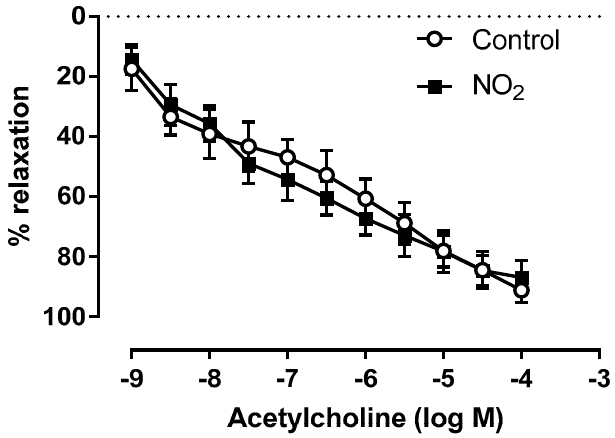
Figure 3. Coronary vasodilation measured after acute NO 2 Figure 3. coronary vasodilation measured after acute NO 2 exposure.